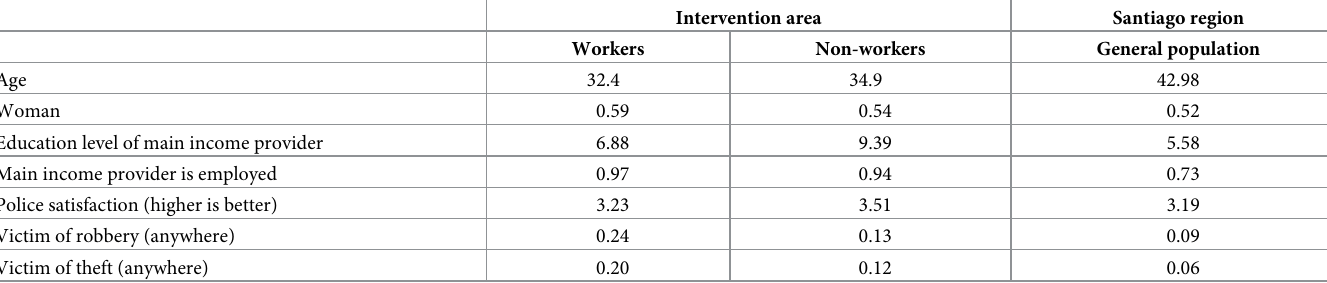
Table 2. Descriptive statistics for workers, non-workers, and regional